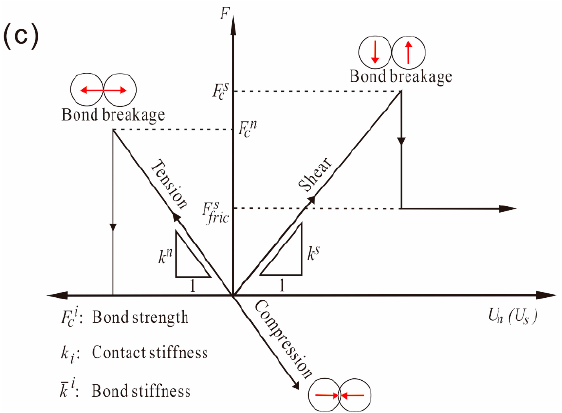
Figure 6. Bonded particle model in PFC2D: ( a ) Schematic of bonded particle model; ( b ) the micro-scale parameters of the bond at contacts; and ( c ) the deformation and failure mechanisms of the bond under tensile and shear stress (modified from Bahaaddini et al. [48]).